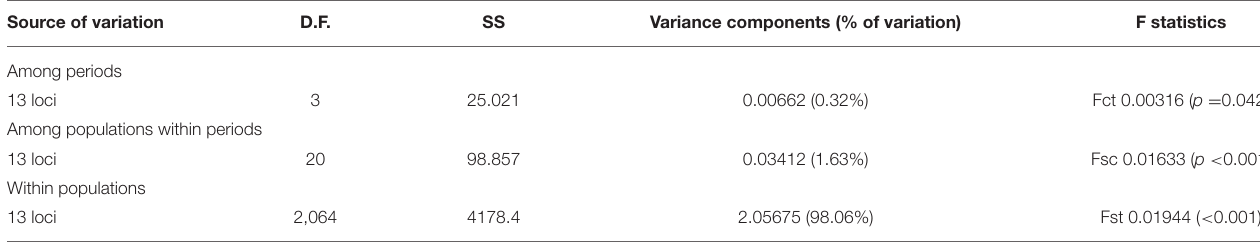
TABLE 5 | Hierarchical AMOVA based on sampling periods. Source of